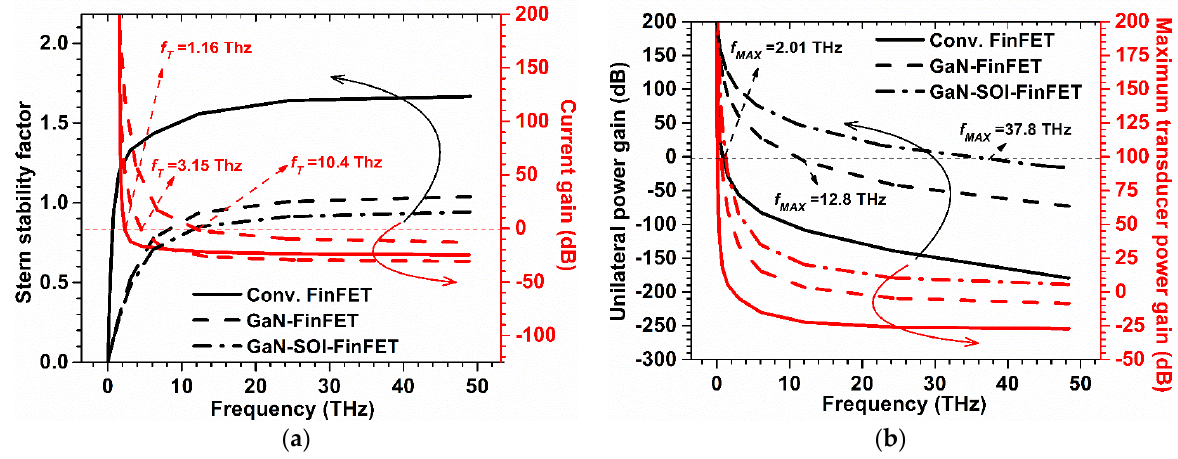
Figure 5. ( a ) SS and Current Gain for Conventional and GaN-SOI-FinFET. ( b ) Unilateral Power Gain and G MT for Conventional and GaN-SOI-FinFET.